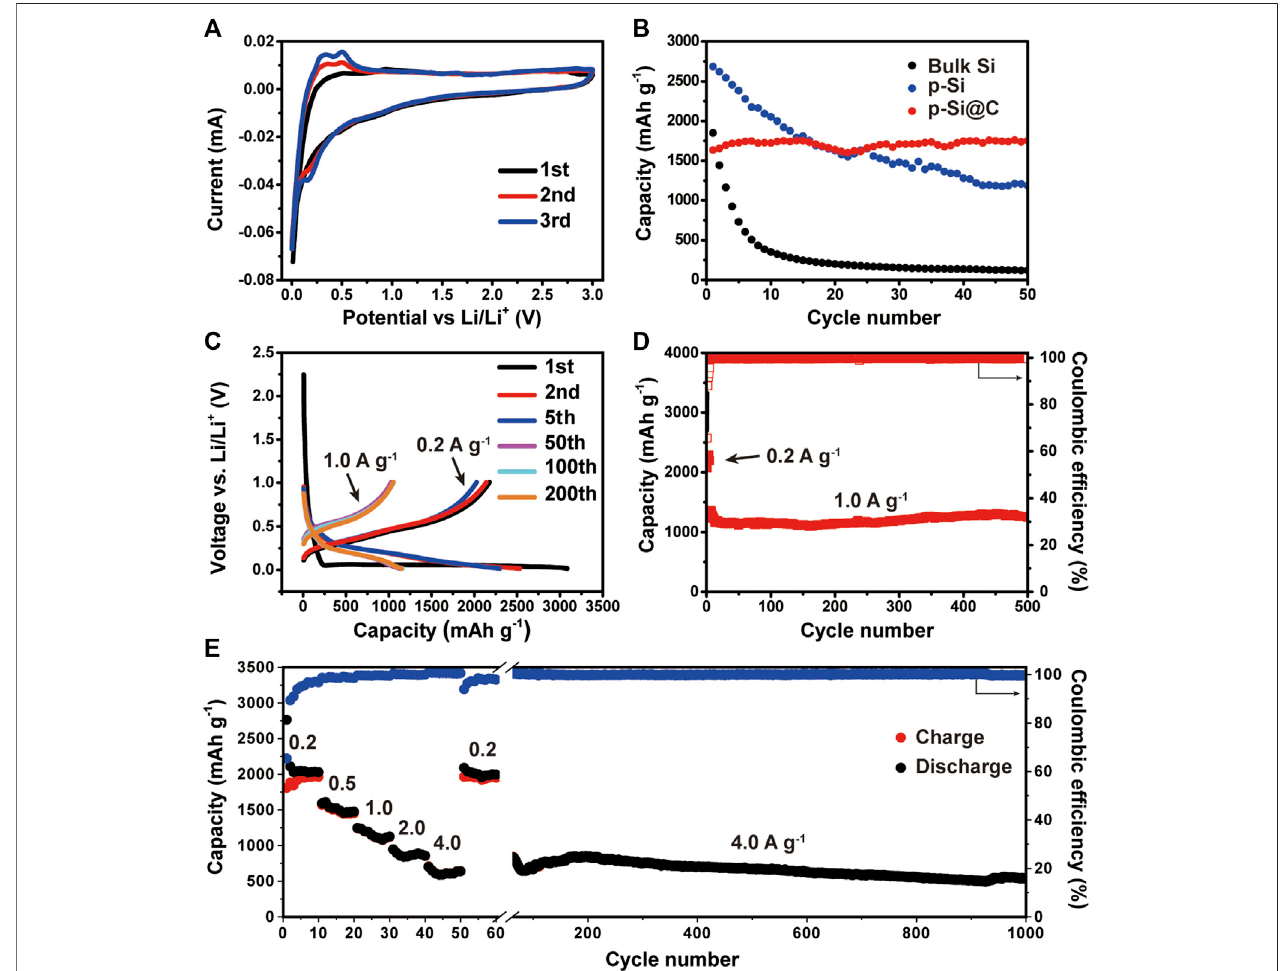
FIGURE3|(A) CVcurvesofmacroporousSi@Ccomposites. (B) Cyclingperformanceofbulksilicon,macroporoussilicon,andmacroporousSi@Ccompositesat the same current density of 0.5 A g − 1 . (C) Voltage pro fi les of the macroporous Si@C composites for the fi rst, second and fi fth cycles at 0.2 A g − 1 and the 100th, 200th and 500th cycles at 1.0 A g − 1 . (D) Cycling performance of macroporous Si@C composites. (E) Rate capabilities of macroporous Si@C composites under different current densities.